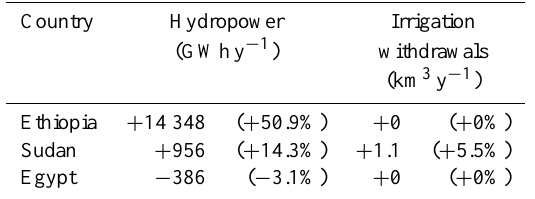
Table 3. Benefits from upstream regulation (difference between S3 and S4).